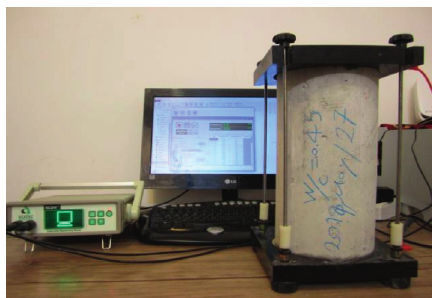
Figure 4: Electrical resistance specimens test.